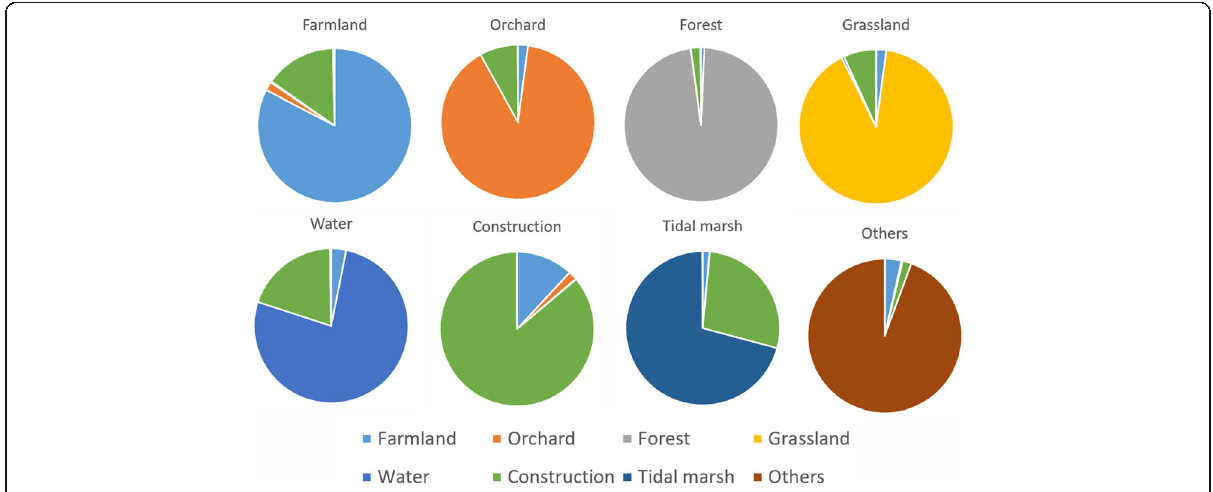
Fig. 4 Land use transition pie chart from 2006 to planning year